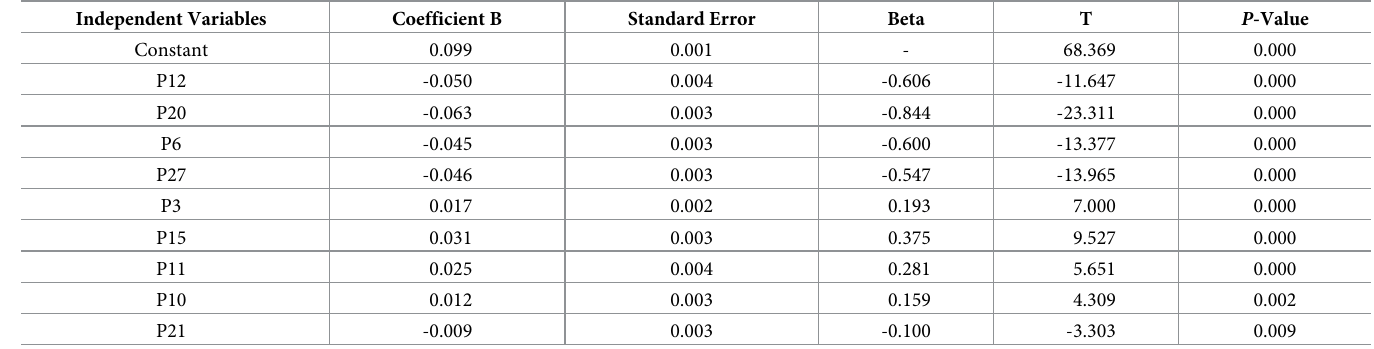
Table 10. Summary of model variables for schedule performance in reconstruction